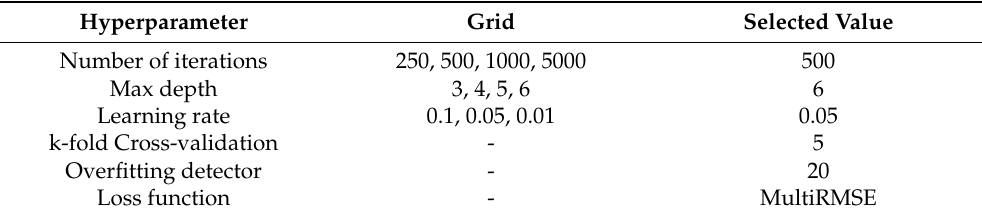
Table 1. Grid search